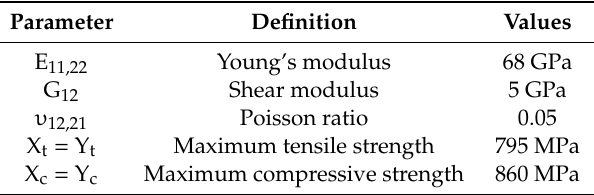
Table 1. Mechanical properties of the CFRP laminate.